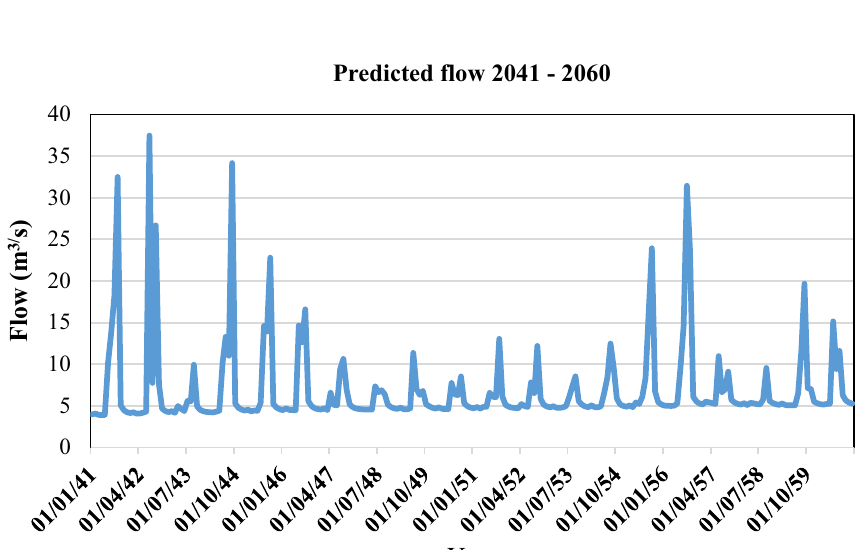
Fig. 7 Future predicted